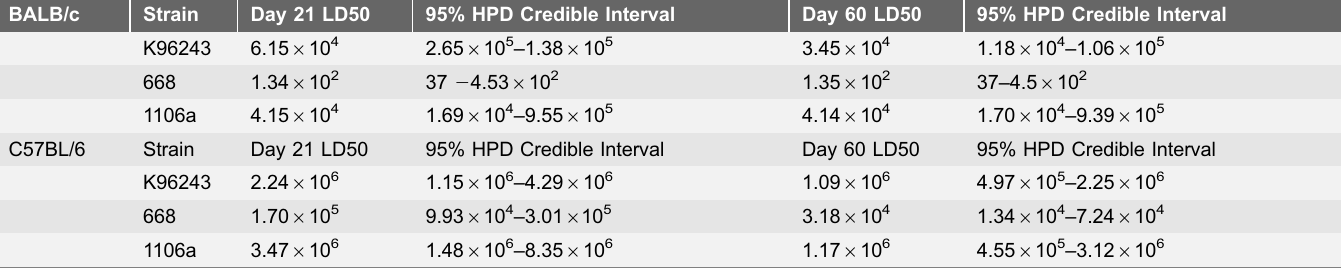
Table 1. LD 50 values from intraperitoneal exposure of BALB/c and C57BL/6 mice to B. pseudomallei strains MSHR668, K96243 and 1106a.